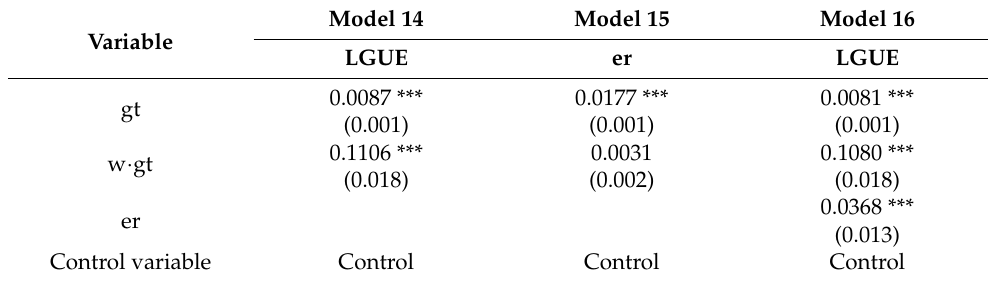
Table 8. Mechanism test results (Environmental